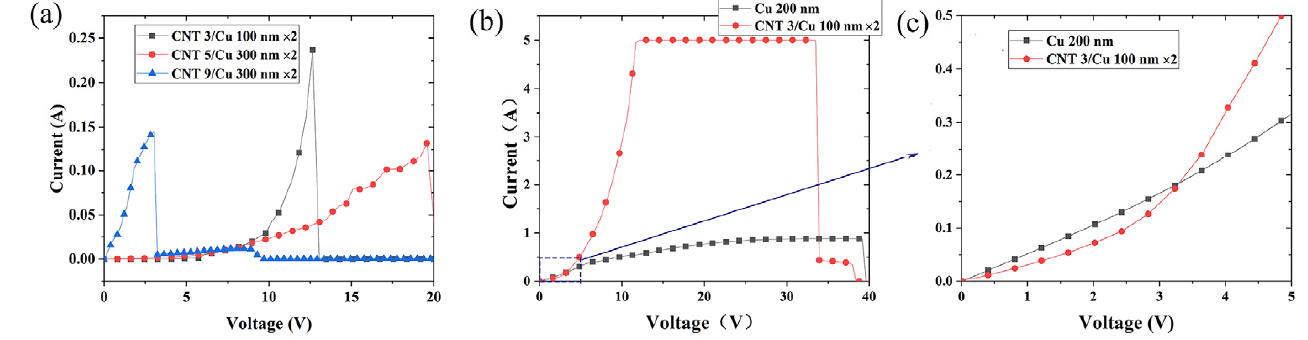
Figure 4. The meaning of the label, e.g., CNT 3/Cu 100 nm ×2 means the sample is made up of three layers of SACNT film and 100 nm Cu film with two cycles. ( a ) I–V curves of the various layers CNT– Cu composites with higher current-carrying samples. ( b ) Comparison of I–V curves between pure Cu wire and CNT–Cu composite wire, and enlargement in the dotted red box ( c ).